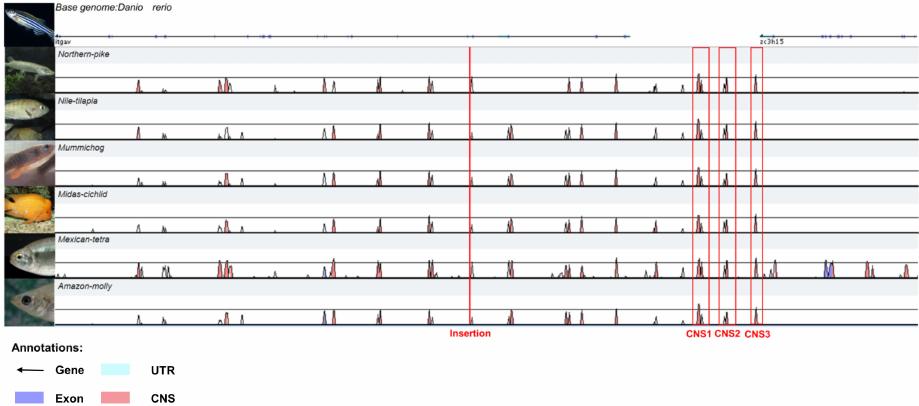
Figure 4. Enhancer distribution between 50 kb upstream and 50 kb downstream of the insertion site in the EYE lines genome. Genomic sequences from Danio rerio , Northern-pike , Nile-tilapia , Mummi- chog , Midas-cichlid , Mexican tetra , and Amazon-molly were analyzed in the VISTA browser. The red boxes represent three conserved non-coding sequences (CNS) that are predicted to be enhancers between itgav and zc3h15 genes . The red arrow indicates the insertion site of the ET vector. UTR: untranslated